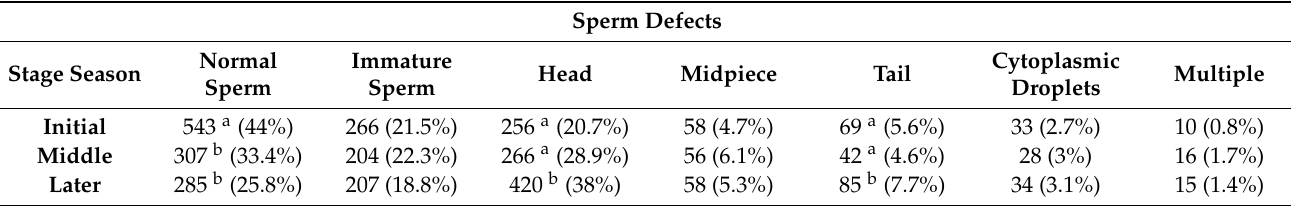
Table 1. Classification and incidence of falcon sperm defects determined at the initial, middle, and later stages of the reproductive season; values are expressed as n (%); ( n = 3258).